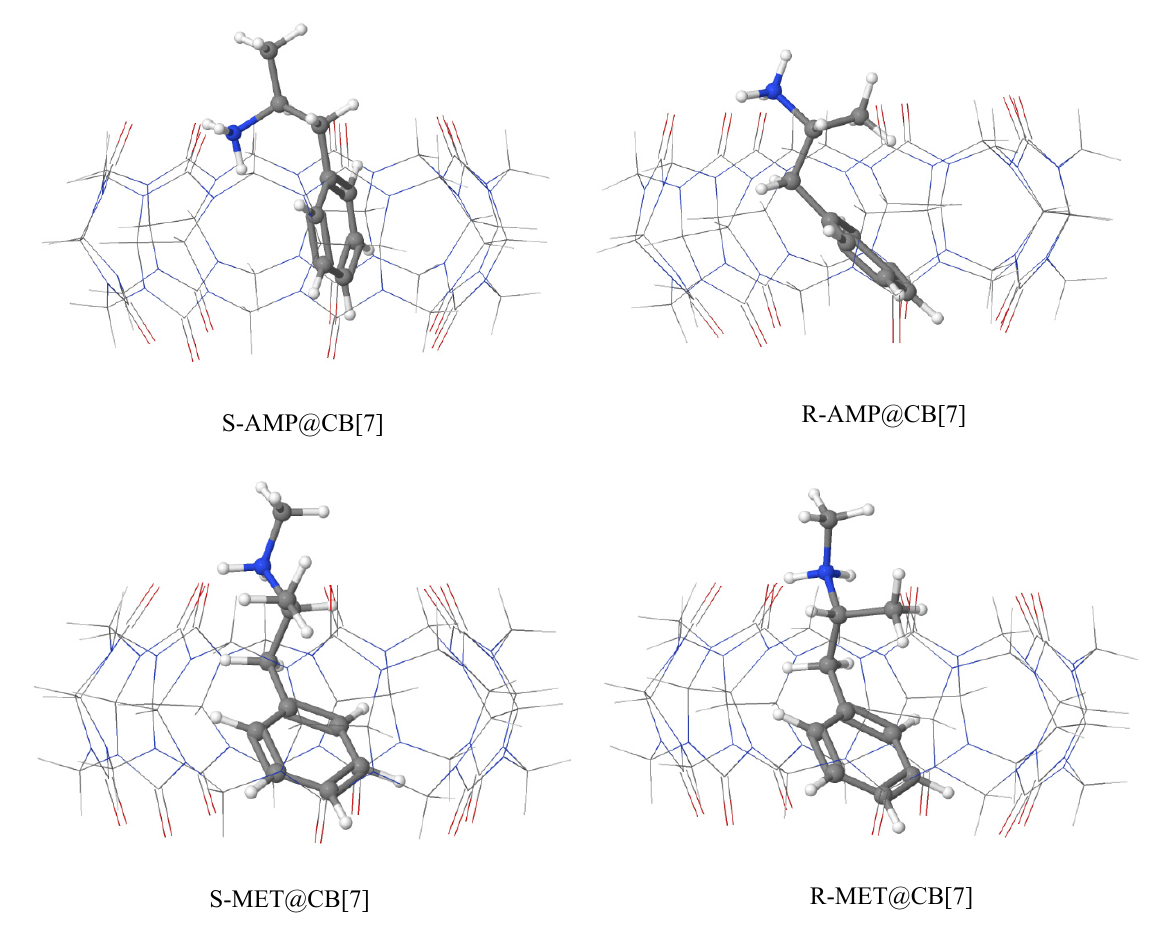
Figure 2. Structures of the most stable conformations optimized at BLYP-D4-def2-TZVP-gCP level in aqueous phase.